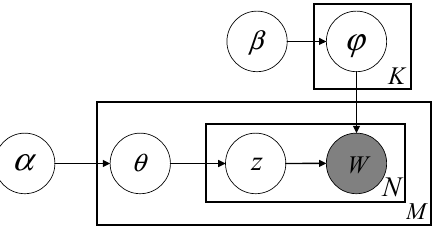
Figure 1. LDA Bayesian network structure.